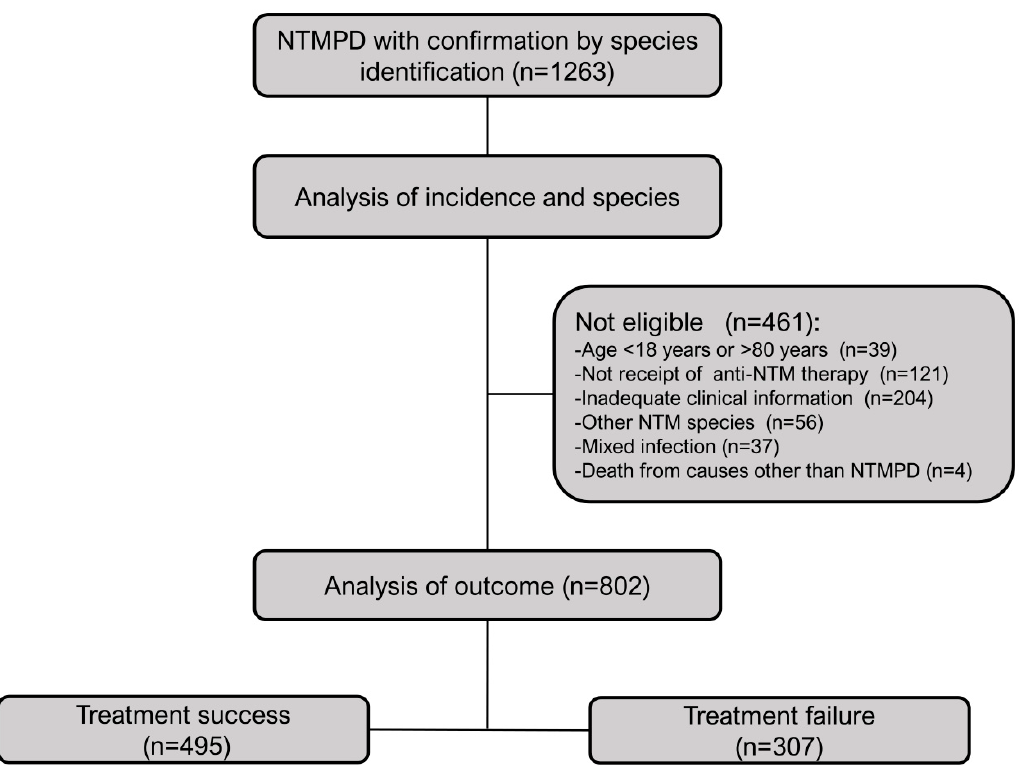
Figure 1. Identification and disposition of patients with NTMPD. NTMPD: nontuberculous myco- bacterial pulmonary disease, and NTM: nontuberculous mycobacteria. terial pulmonary disease, and NTM: nontuberculous